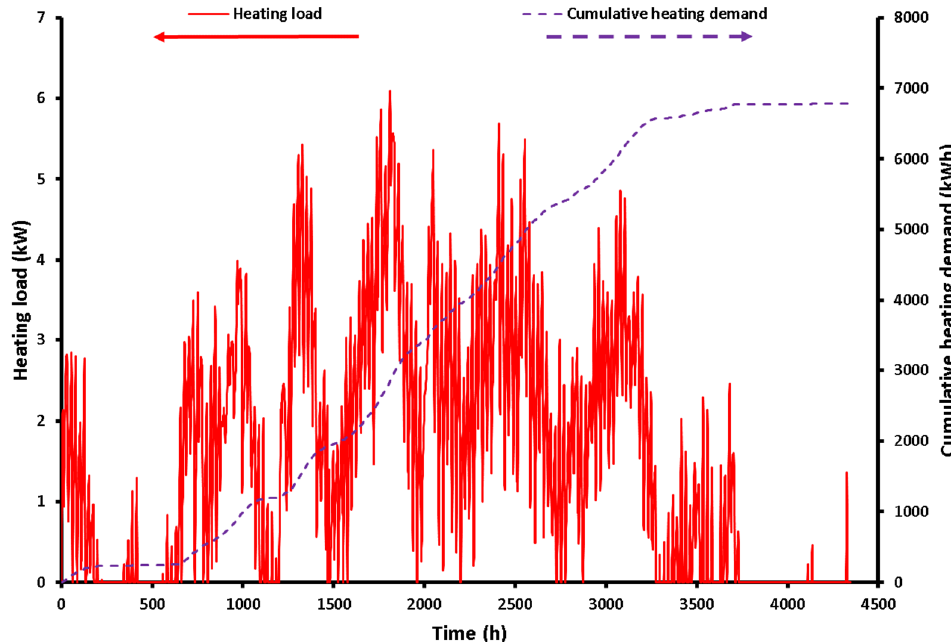
Figure 5. Heating load and cumulative heating demand for the examined building (1 October to 30 April). 30 April).